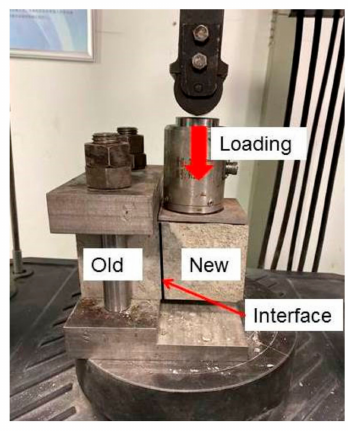
Figure 1. Shear fixture.